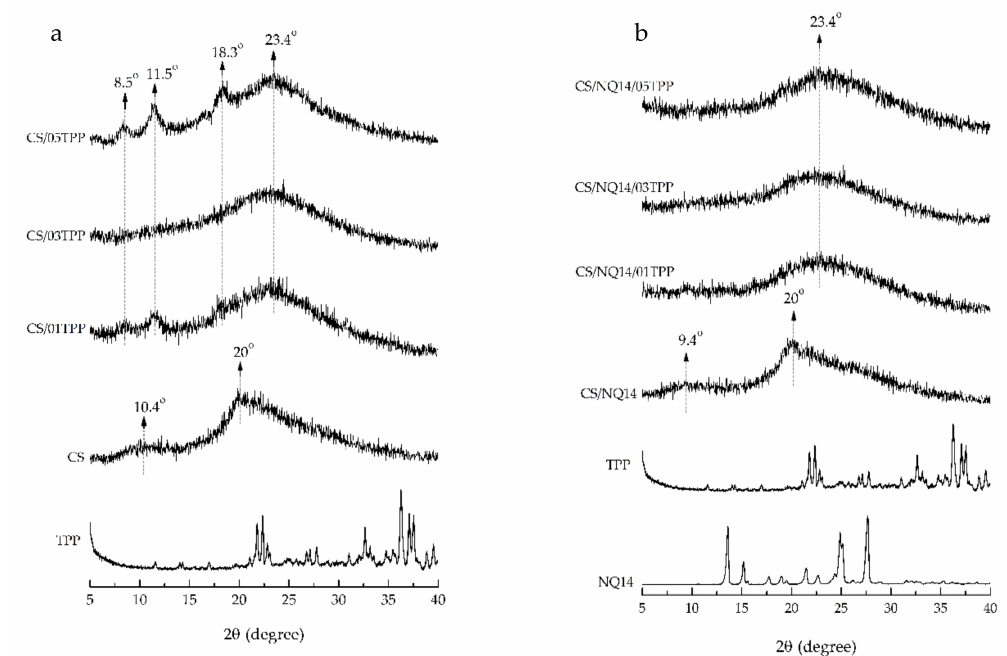
Figure 4. Wide-angle X-ray diffraction (WAXD) profiles of TPP, non-crosslinked and ionically crosslinked chitosan membranes before NQ14 drug loading ( a ); NQ14, TPP, and non-crosslinked and ionically crosslinked chitosan membranes after NQ14 drug loading ( b